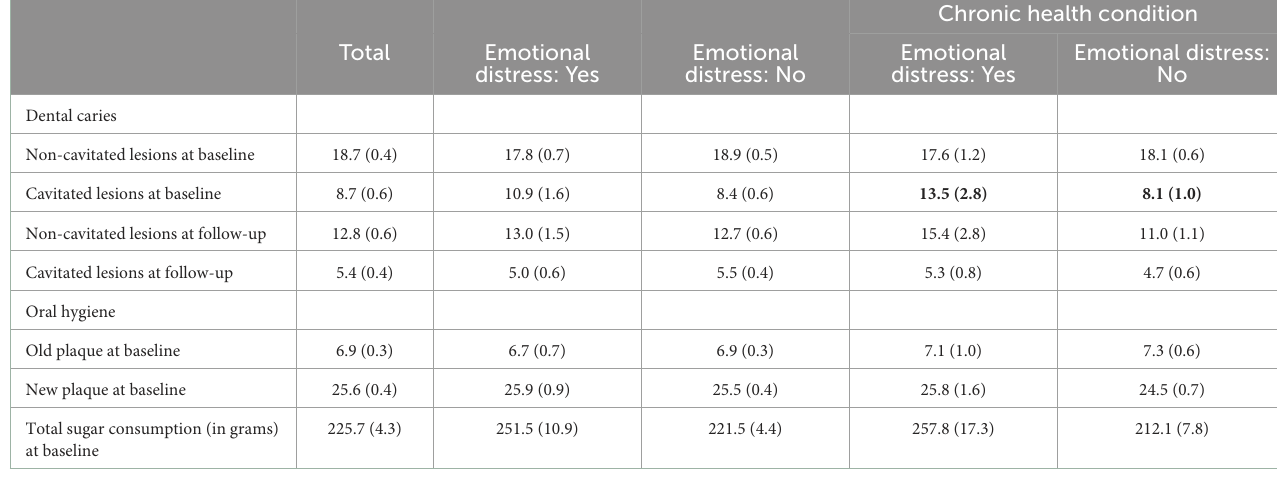
TABLE 2 Dental caries and oral hygiene at baseline and follow-up among African-American caregivers, Detroit, Michigan, 2002–2007.